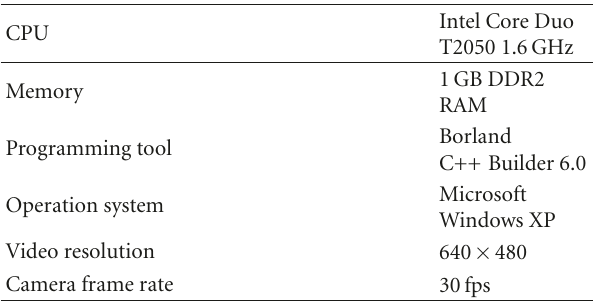
Table 1: The specifications of our working platform. Table 2: The runtime in each processing step in Figure